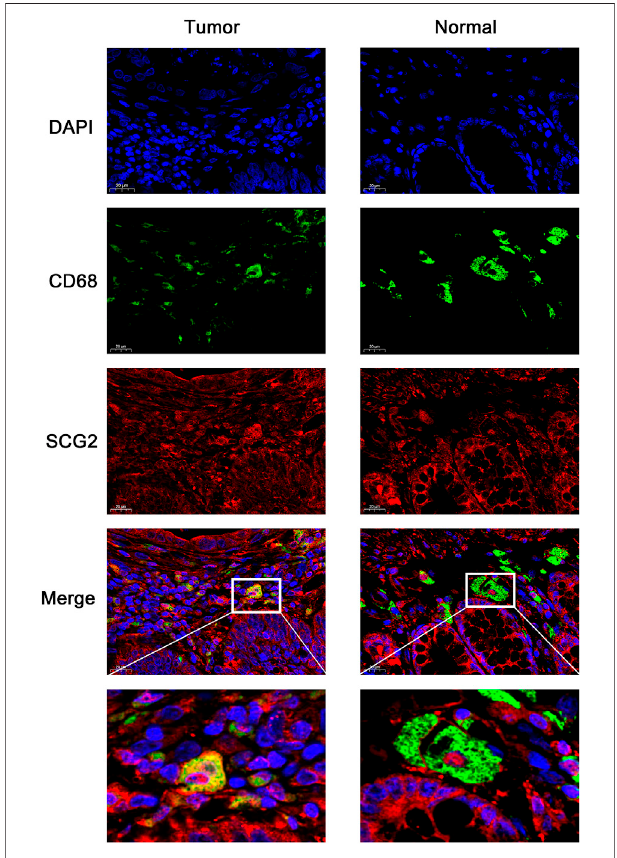
FIGURE 7 | Immuno fl uorescence images of DAPI (blue), CD68 (green), SCG2 (red), and the merge photos in normal tissues and cancer tissues of CRC